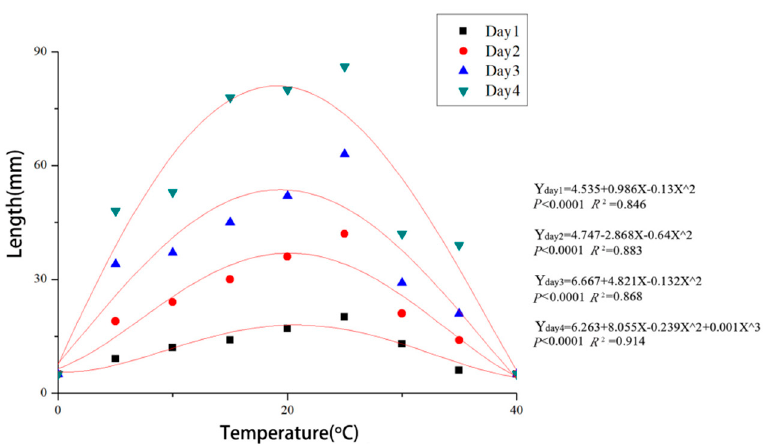
Figure 5. Regression curves and equations for mycelial growth of Cytospora haidianensis after incubation for 24, 48, 72 and 96 h at 0, 5, 10, 15, 20, 25, 30, 35 and 40 °C on PDA medium (X = temperature (°C), Y = growth (colony diameter, mm)). Optimal mycelial growth temperature was estimated to be 19.8 °C.